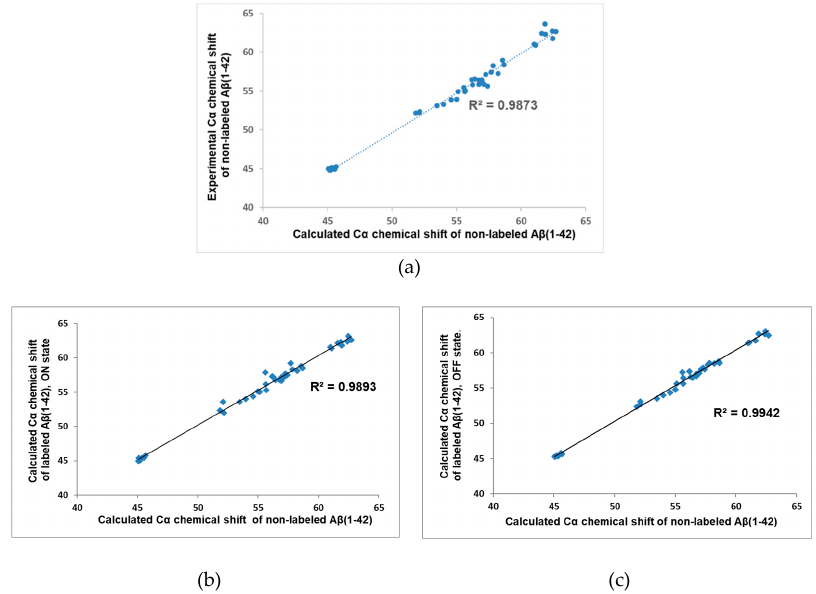
Figure 1. ( a ) Comparison of experimental and calculated C α chemical shifts taking the non-labeled A β (1-42). Comparison of calculated labeled C α chemical shifts of A β (1-42) peptide in the ON-state ( b ) and in the OFF-state ( c